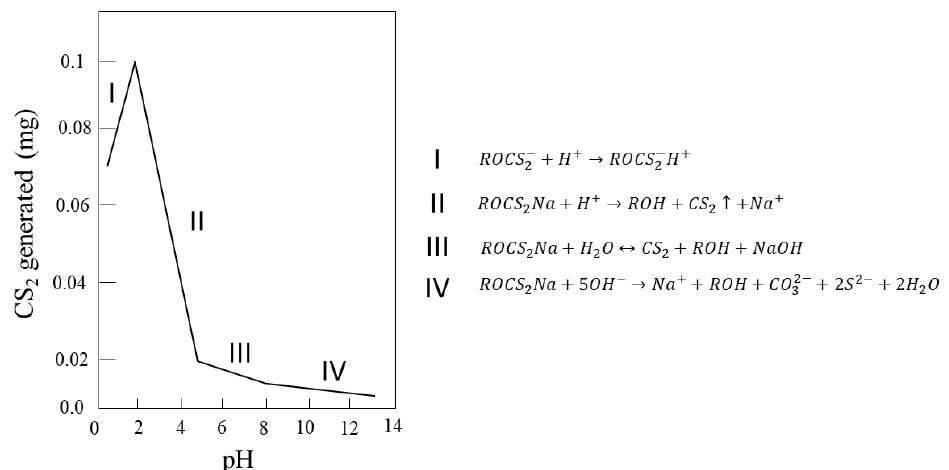
Figure 9. The half-life time of ethyl xanthate as a function of pH (adapted from Allison [32]).